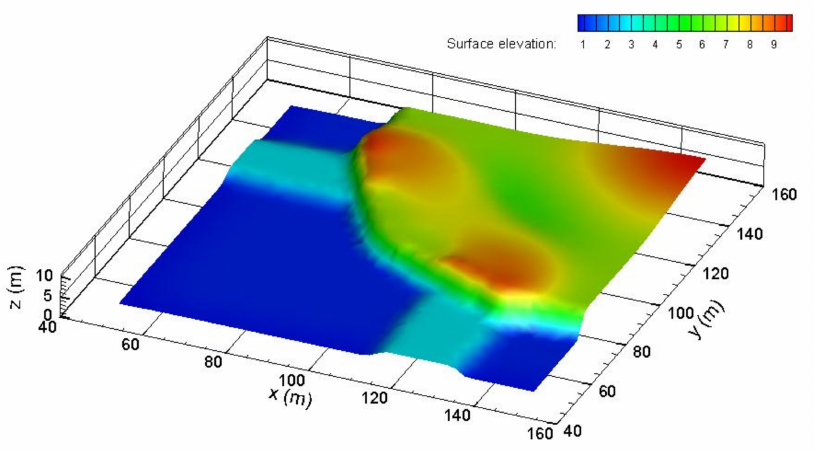
Figure 23. Simulated water surface of the 2D Riemann problem in 3D view at t = 4 s.